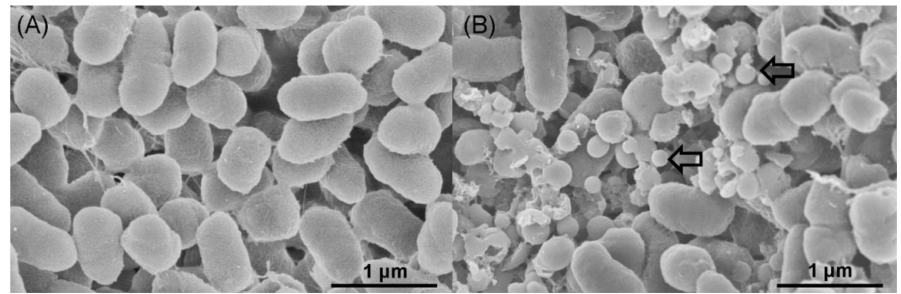
Figure 4. TEM images of A. faecalis Se03 in ( A ) the absence and ( B , C ) presence of 5mM selenite after 36 h incubation. Electron-dense nanoparticles (white arrows) located extracellularly ( B ) or intracellularly ( C ). Red arrows indicate “empty ghost” cells.